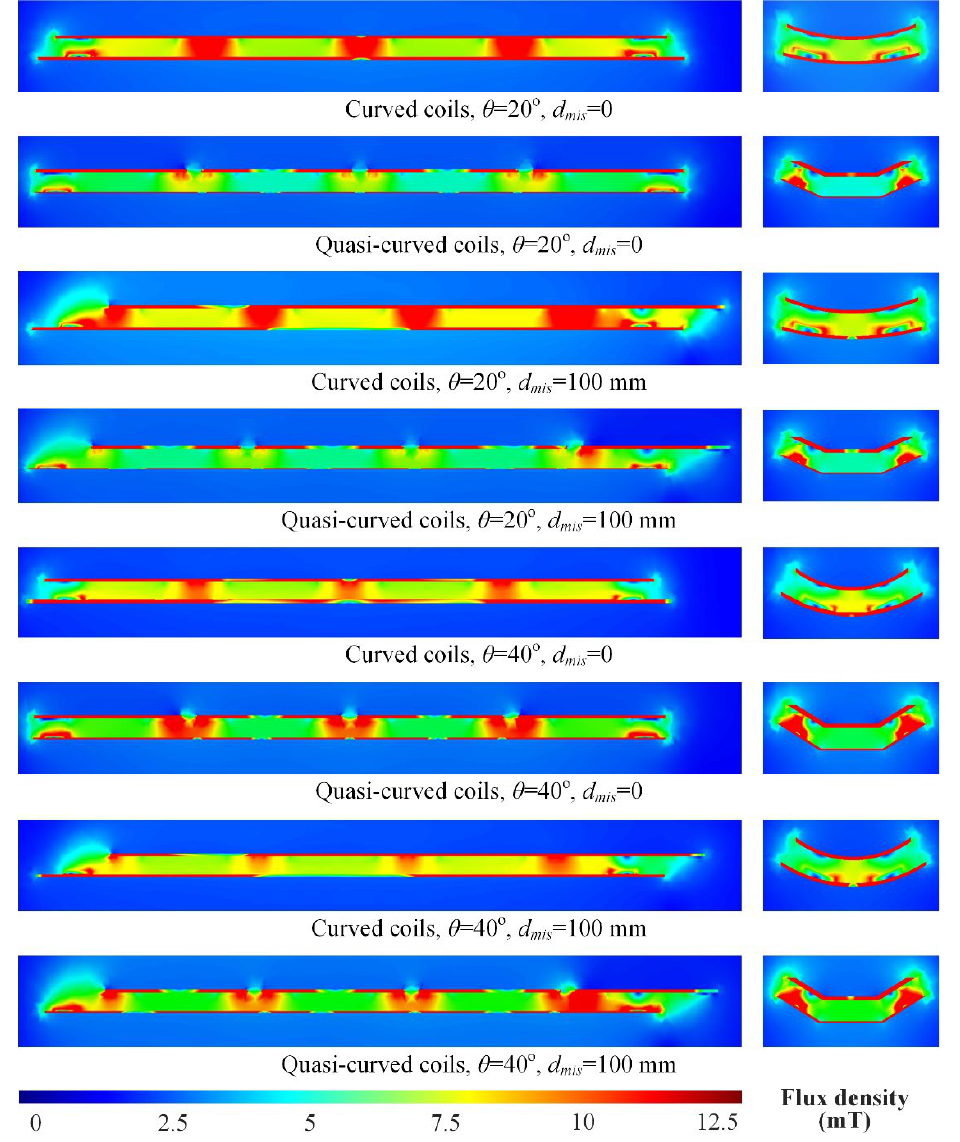
Figure 12. Field distribution of UWCS with different coil topologies, θ and misalignment conditions: side view ( left ) and front view ( right ).